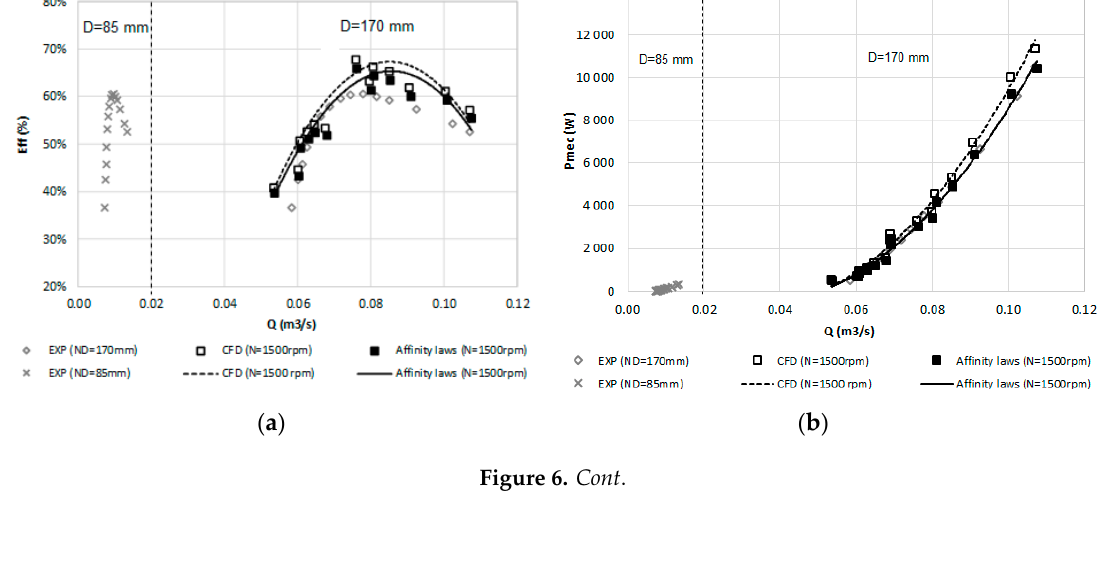
Figure 5. Hill charts obtained from numerical simulations: ( a ) Efficiency vs. flow and rotational speed; ( b ) Efficiency vs. flow and head; ( c ) Mechanical power vs. flow and head.